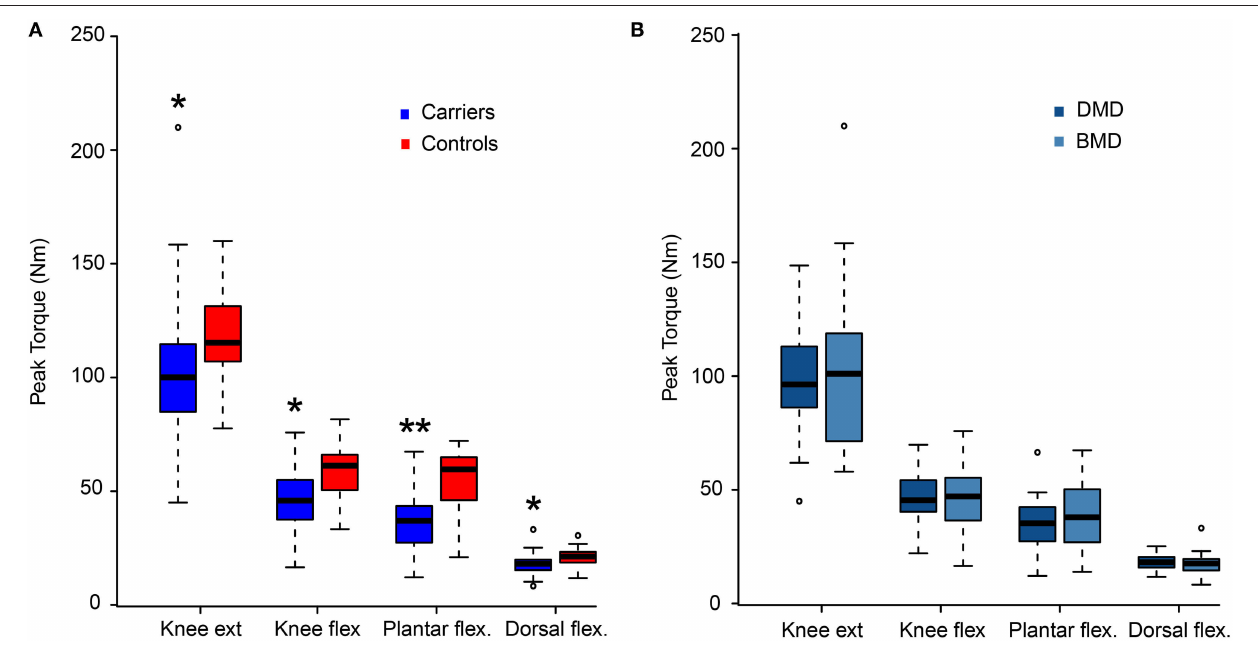
FIGURE 2 | Dynamometry results. Maximum strength presented as peak torque comparing women with pathogenic variants in DMD and healthy women (Controls) (A) , and comparison between women with variants predicted to result in Duchenne muscular dystrophy (DMD) and Becker muscular dystrophy (BMD) (B) . Presented as median value and four quartiles. ext, extension; flex, flexion; Nm, Newton meter; * p < 0.05 and ** p < 0.001 vs.